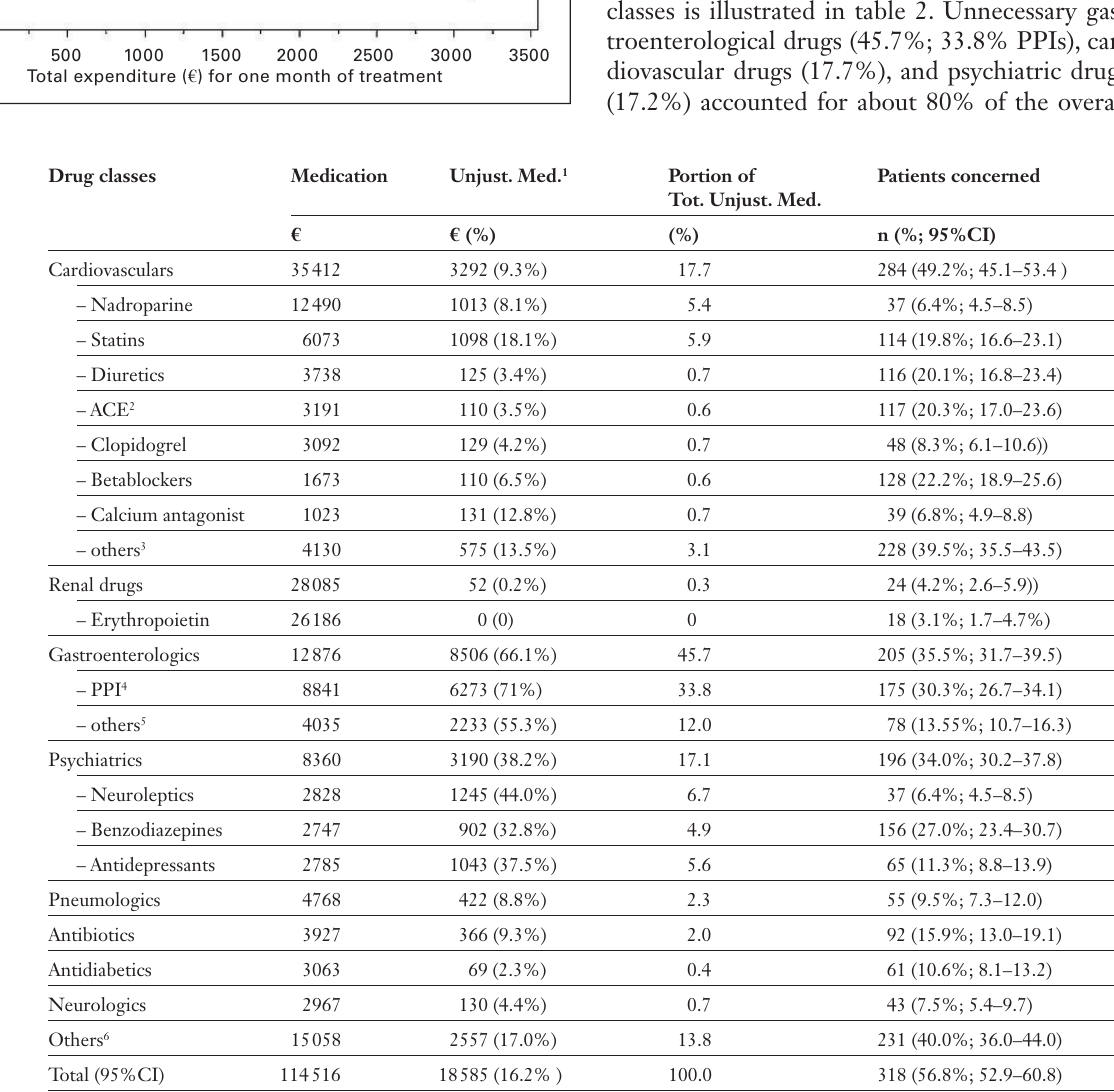
figure 1: the lower the amount, the higher the percentage of unnecessary treatments.